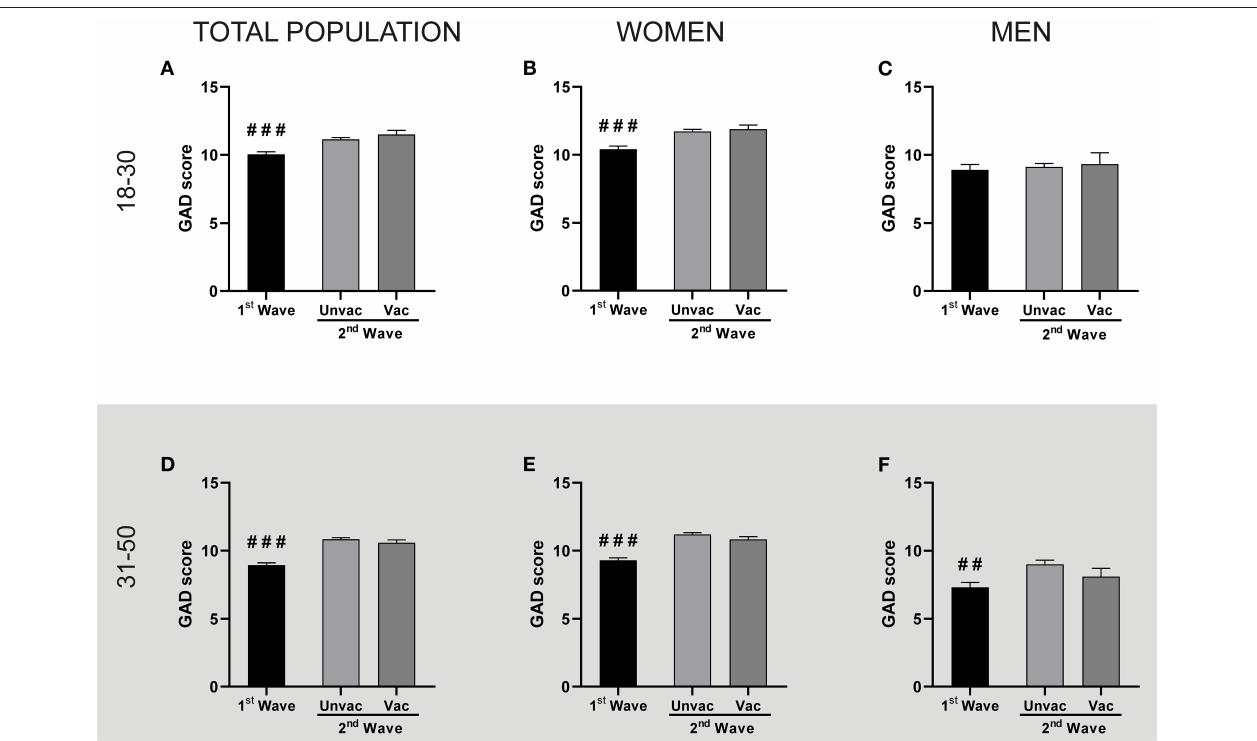
FIGURE 3 | The vaccination status did not correlate with GAD levels changes. Each panel compares the GAD scores reported by the unvaccinated people during the 1st and the 2nd wave, and the GAD scores between unvaccinated (Unvac) and vaccinated (Vac) people within the 2nd wave, by two independent Mann-Whitney U -test. Data shown as mean + SEM. The descriptive statistics are reported in Supplementary Table 3 . Top panel: People aged between 18 and 30. (A) Total population: ### p < 0.001 vs. unvaccinated; Cohen’s d = 0.21; (Unvac 1st wave n = 685; unvaccinated n = 1,538; vaccinated n = 303). (B) Women: ### p < 0.001 vs. unvaccinated; Cohen’s d = 0.26 (1st wave n = 514; unvaccinated n = 1,195; vaccinated n = 259). (C) Men: (1st wave n = 171; unvaccinated n = 343; vaccinated n = 44). Bottom panel: People aged between 31 and 50. (D) Total population: ### p < 0.001 vs. unvaccinated; Cohen’s d = 0.38 (Unvac 1st wave n = 846; unvaccinated n = 2,035; vaccinated n = 692). (E) Women: ### p < 0.001 vs. unvaccinated; Cohen’s d = 0.39 (1st wave n = 700; unvaccinated n = 1,709; vaccinated n = 633). (F) Men: ## p < 0.01 vs. unvaccinated; Cohen’s d = 0.40 (1st wave n = 146; unvaccinated n = 326; vaccinated n =